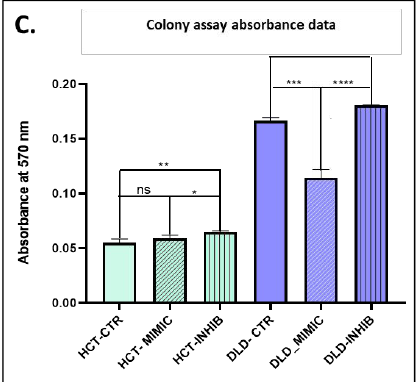
Figure 5. The effects of miR-125b replacement/inhibition on colon cancer cell self-renewal capacity. ( A ) Colony assay for DLD-1 cell line: top—colony assay pictures Control, miR-125b mimic (100nM) and miR-125b inhibitor (100nM) groups; bottom—graphical representation of the number of colonies and covered area (data presented as mean ± S.D., ns independent t -test compared to control); left— pictures of the individual colonies taken with an inverse optical microscope at 4 × magnification. Experiments were performed in biological duplicates for each cell line and each treatment scheme ( B ) Colony assay for HCT-116 cell line: top—colony assay pictures Control, miR-125b mimic (100 nM) and miR-125b inhibitor (100 nM) groups; bottom—graphical representation of the number of colonies and covered area (data presented as mean ± S.D., ns independent t -test compared to control); left— pictures of the individual colonies taken with an inverse optical microscope at 4 × magnification. Experiments were performed in biological duplicates for each cell line and each treatment scheme ( C ) Graphical representation of the absorbance values and difference between HCT-116/DLD-1 Control, miR-125b mimic (100 nM), and miR-125b inhibitor (100 nM) groups. Experiments were performed in biological duplicates for each cell line and each treatment scheme (data presented as mean ± S.D., ** p = 0.0024 for HCT-116 treated with miR-125b inhibitor independent t -test compared to HCT-116 control; * p = 0.0130 for HCT-116 treated with miR-125b mimic independent t -test compared to HCT-116 treated with miR-125b inhibitor control; *** p = 0.0001 for DLD-1 treated with miR-125b mimic independent t -test compared to DLD-1 control; *** p = 0.0014 for DLD-1 treated with miR-125b inhibitor independent t -test compared to DLD-1 control; **** p < 0.0001 for DLD-1 treated with miR- 125b mimic independent t -test compared to DLD-1 treated with miR-125b inhibitor). The absorbance was measured after dilution of crystal violet colored colonies and is attributed to the number of colonies